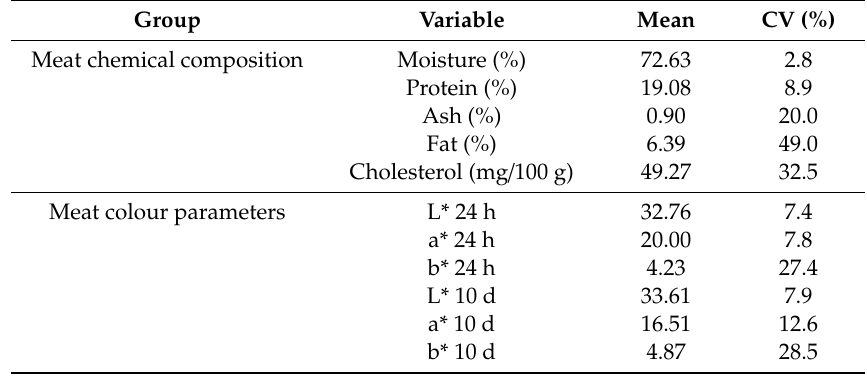
Table 1. Mean and coe ffi cient of variation (CV) for meat chemical composition, colour parameters, physical properties and fatty acid profiles (in % of total fatty acids) in l. thoracis samples obtained from 160 B. indicus and B. taurus bulls finished on grain or